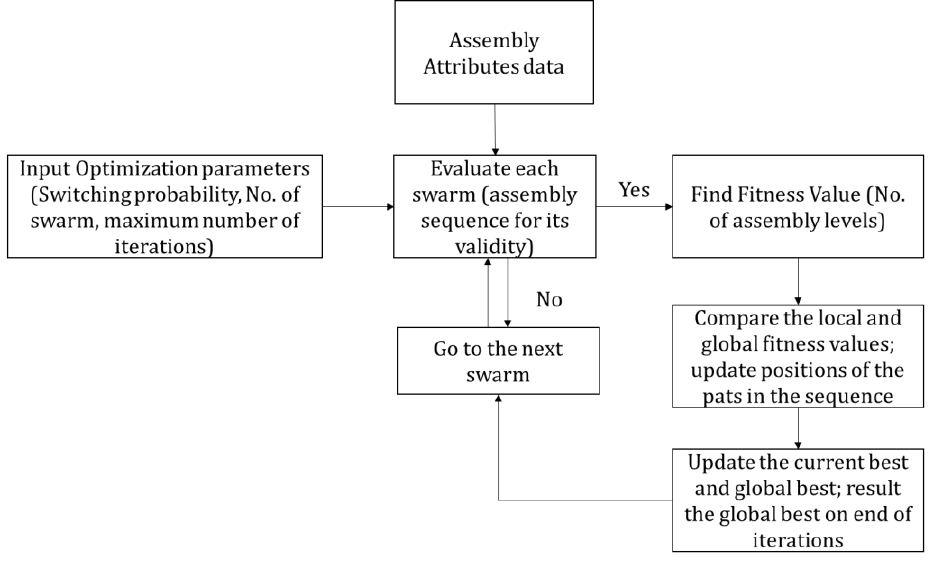
Figure 3. Flow diagram of ESWSA for assembly sequence